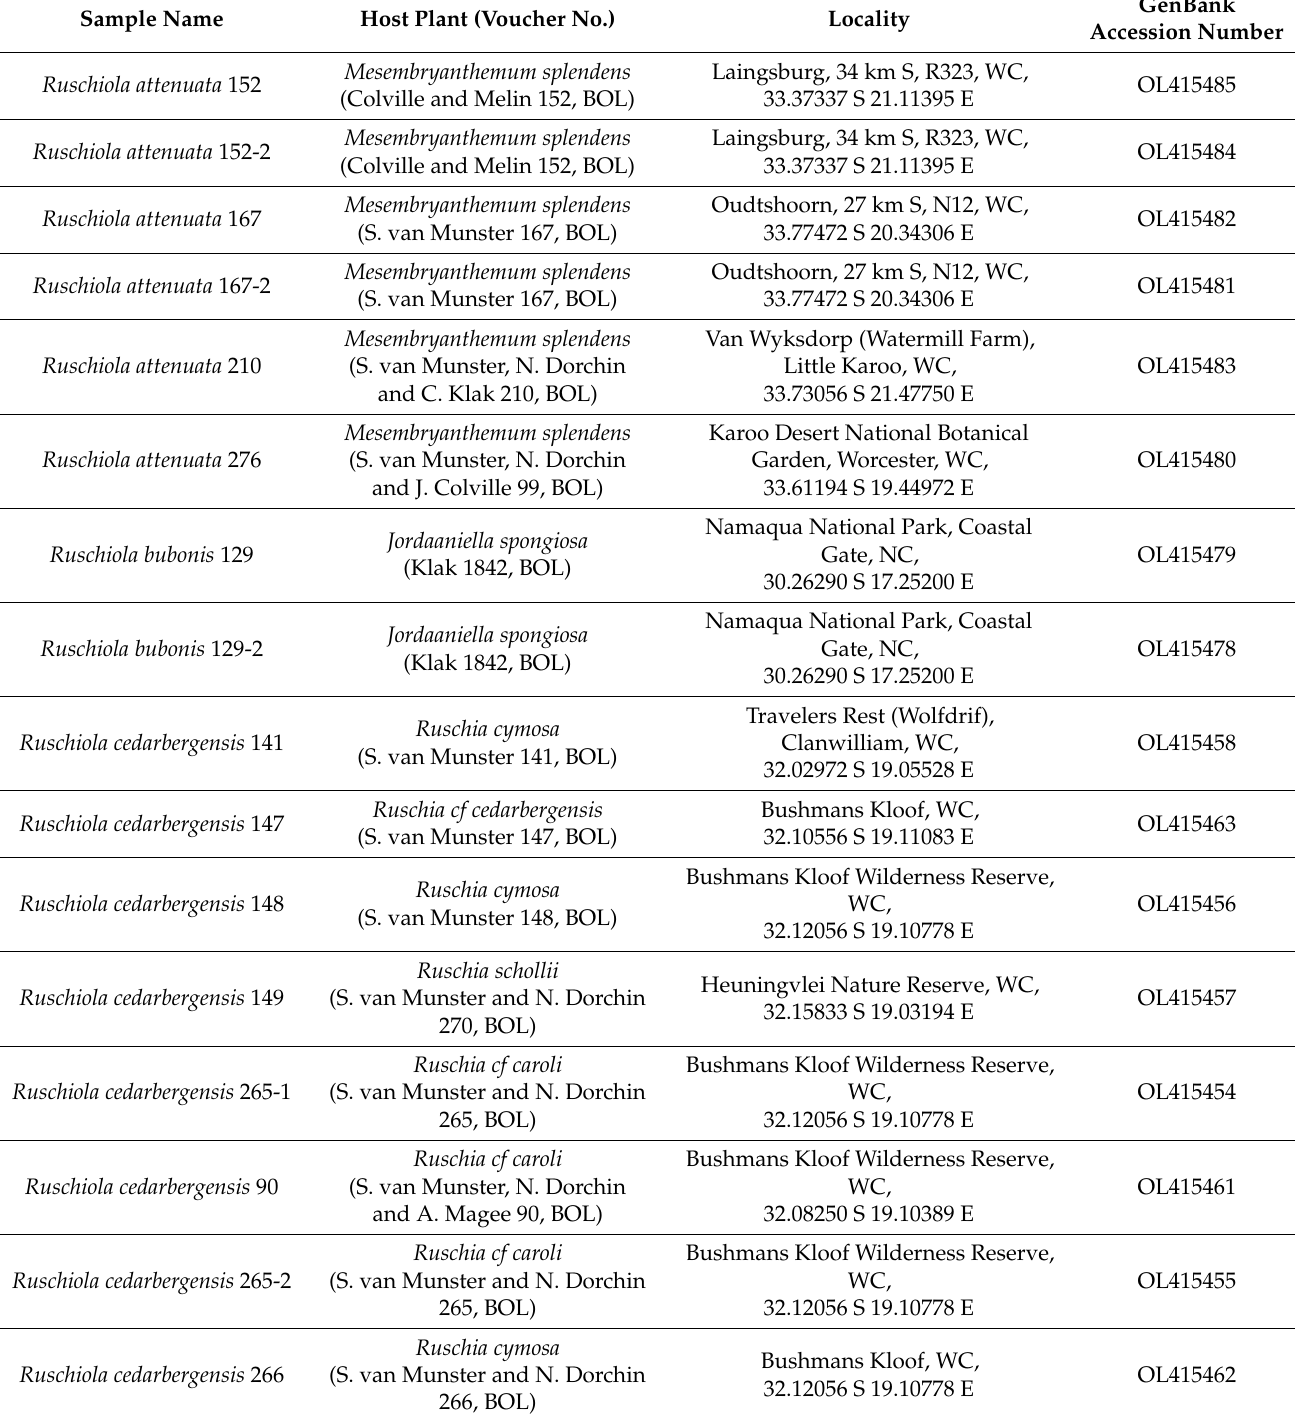
Table 1. Individuals used in the molecular analysis with the data collection information and Gen- Bank accession numbers. All individuals were collected in South Africa (WC: Western Cape; NC: Northern